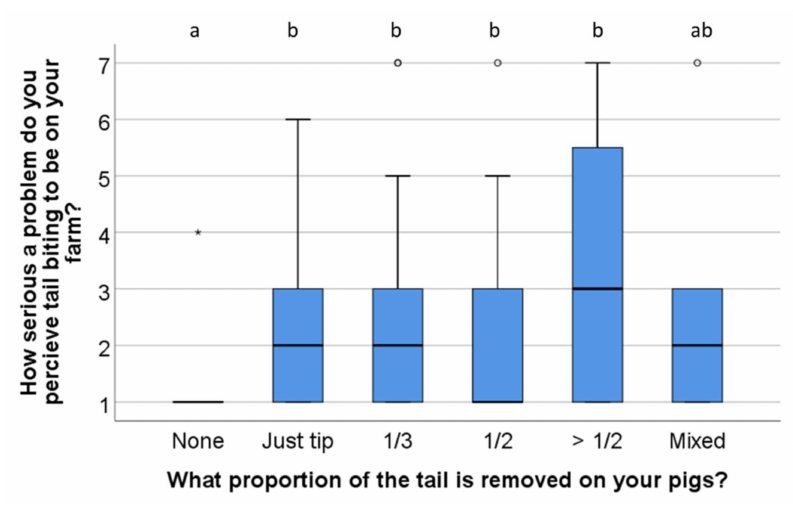
Figure 4. Distribution of scores for perceived seriousness of tail biting problem on the respondents’ farms ( n = 176), divided by which proportion of tails is docked on the farm (1—not a serious problem to 7—an extremely serious problem). The boxplot indicates medians and quartiles (25% and 50%) as well as outliers. Boxes lacking common letters di ff er ( p <